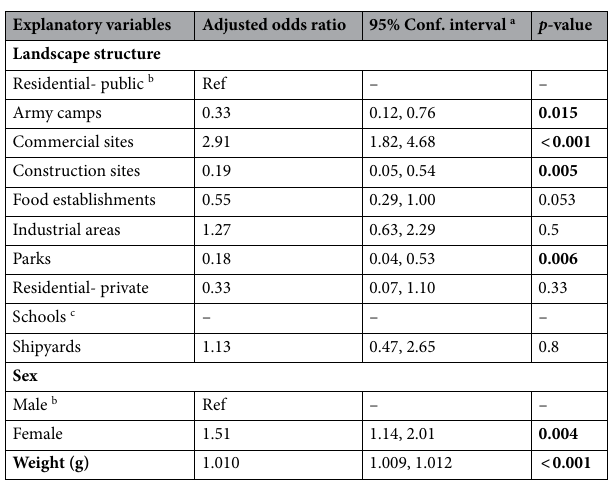
Table 3. Multivariable logistic regression model for Leptospira spp. detection in Rattus rattus and Rattus norvegicus . Significant values ( P < 0.05) are shown in bold. a 95% Confidence Interval. b Reference category. c Omitted from the model because no Leptospira infection was detected at this site.